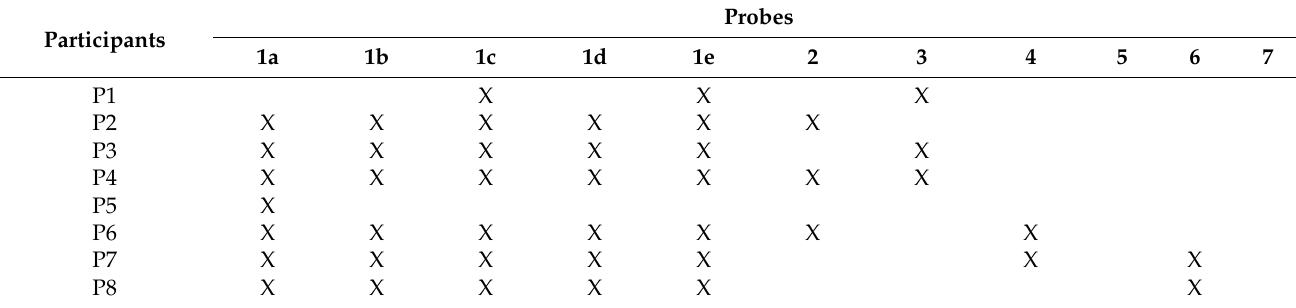
Figure 2. Top-left: Probe 2; Top-right: Probe 3; Bottom-left: Probe 4; Bottom-right: Probe 6 illustrate the format and tone of the probe pack. Table 2. The probes completed by the